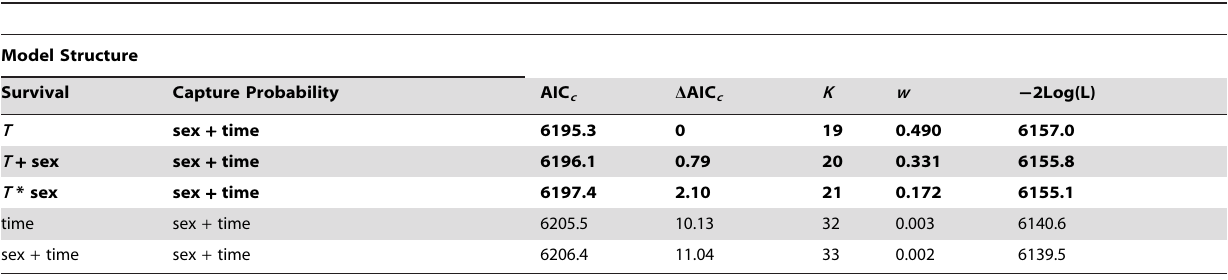
Table 1. Top model results from a candidate model set using tuatara survey data from 1998 – 2011 analyzed using an open mark- recapture population